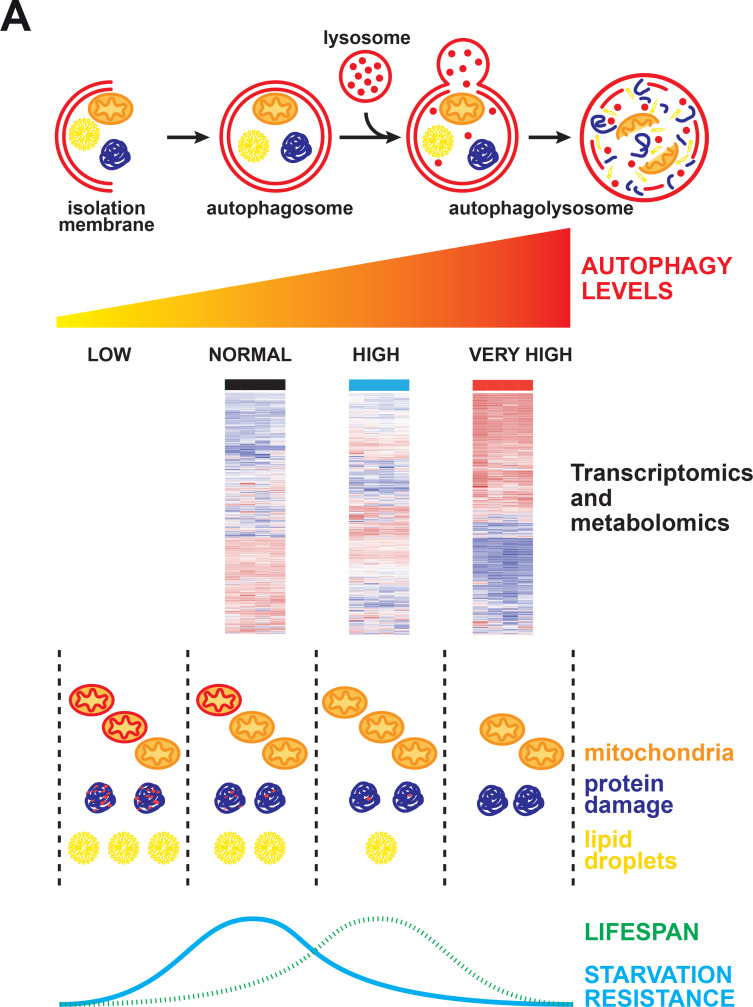
Scheme illustrating the effect of varying Atg1 levels on fly physiology.Organisms with decreased autophagy accumulate damaged macromolecules and organelles, such as mitochondria (damaged mitochondria are represented in red and healthy in orange). Moderate autophagy induction is beneficial for survival, owing to improved damage removal, but leads to compromised survival during starvation, likely as a consequence of the lower lipid content in these flies. Strong Atg1 overexpression does not provide any further longevity benefits, and in fact impairs survival. Moreover, strong Atg1 overexpression is accompanied by induction of an inflammatory response and transcriptional down-regulation of various mitochondrial genes. Overall, the levels of autophagy present in a wild-type organism are optimised for starvation resistance, which is the major stress encountered in nature, rather than for maximised lifespan.